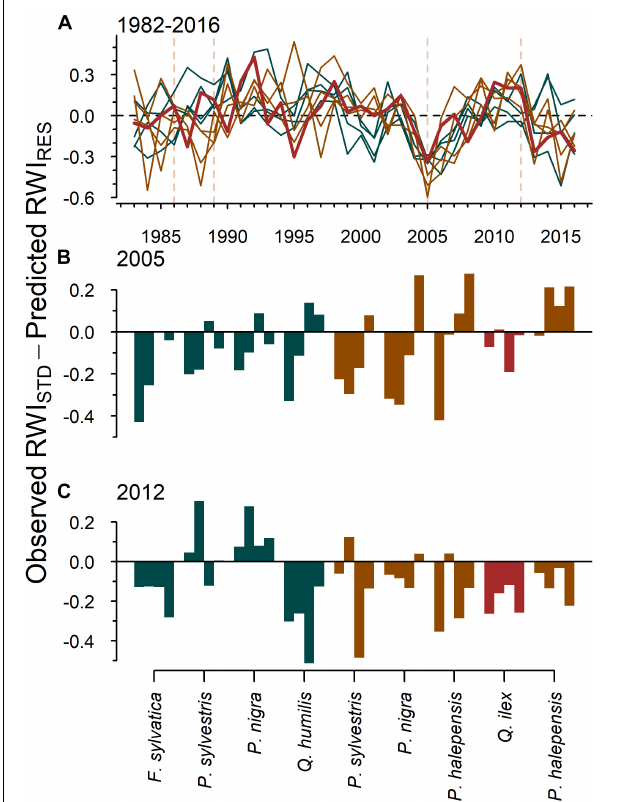
FIGURE 3 | Legacies of drought on tree growth (i.e., pervasive effects of drought on growth that persist after the drought has finished). The figure shows (A) the difference between the standardized growth variability (RWIstd) and the growth (RWIres) predicted by drought (SPEI) for the entire period and 4 years after the (B) 2005 and (C) 2012 droughts, respectively. Negative values indicate that growth was lower than expected by the effect of SPEI (i.e., drought legacies). Dark green colors correspond to the tree species in wet sites and brown colors in dry sites, whilst red bars and lines [plot (A) ] correspond to Holm oak. Dashed vertical lines in plot (A) indicate the studied droughts (i.e., 1986, 1989, 2005, and